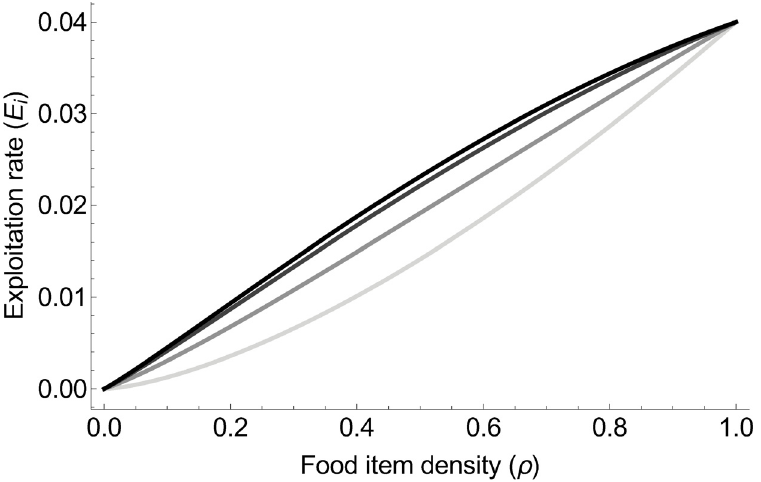
Fig 2. Exploitation rate increases with both food item density and the degree of collective foraging x . The different colors represent different degrees of collective foraging: light grey for x = 0, grey for x = 0.5, dark grey x = 0.8, and black for x =